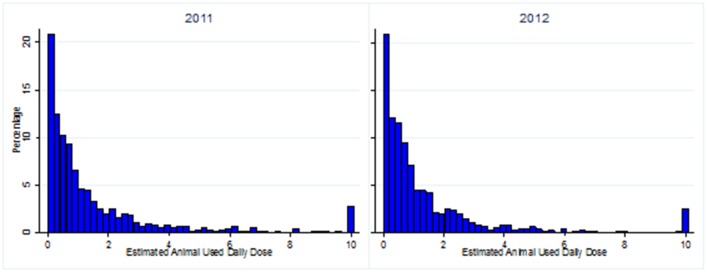
The distribution of the estimated Animal Used Daily Dose of antibiotics per year (AUDD/Y) in farms with small ruminants for which antibiotics were prescribed in 2011 and 2012.Values for AUDD/Y above ten were a rare event and are therefore set at ten for clarity of the figure.